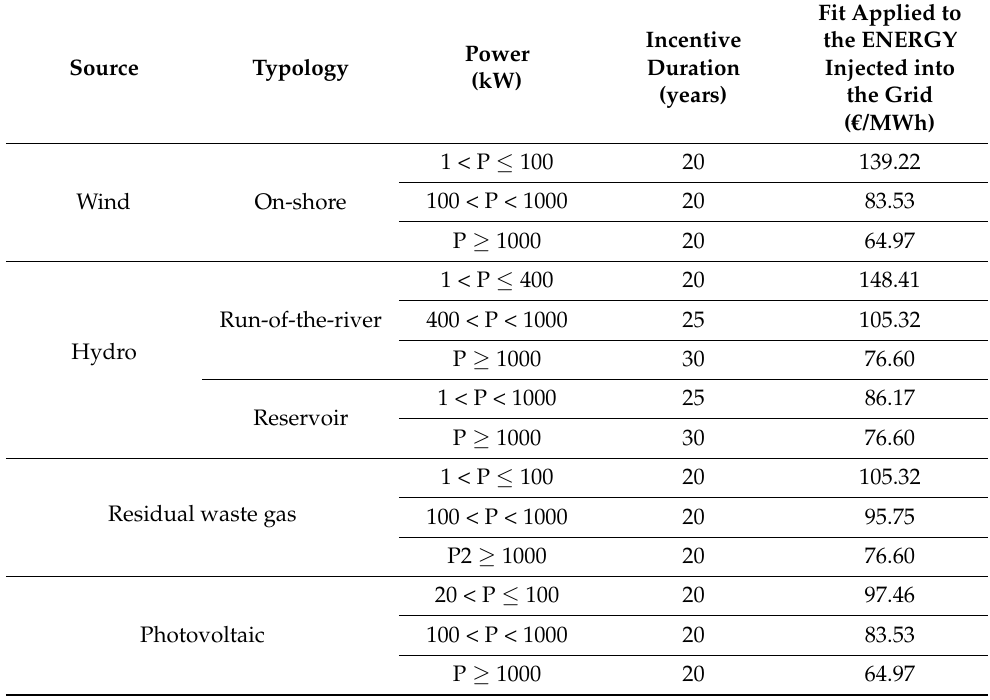
Table 3. FiT applied according to D.M. 4 July 2019 (D.M. FER) to PU connected to the MV